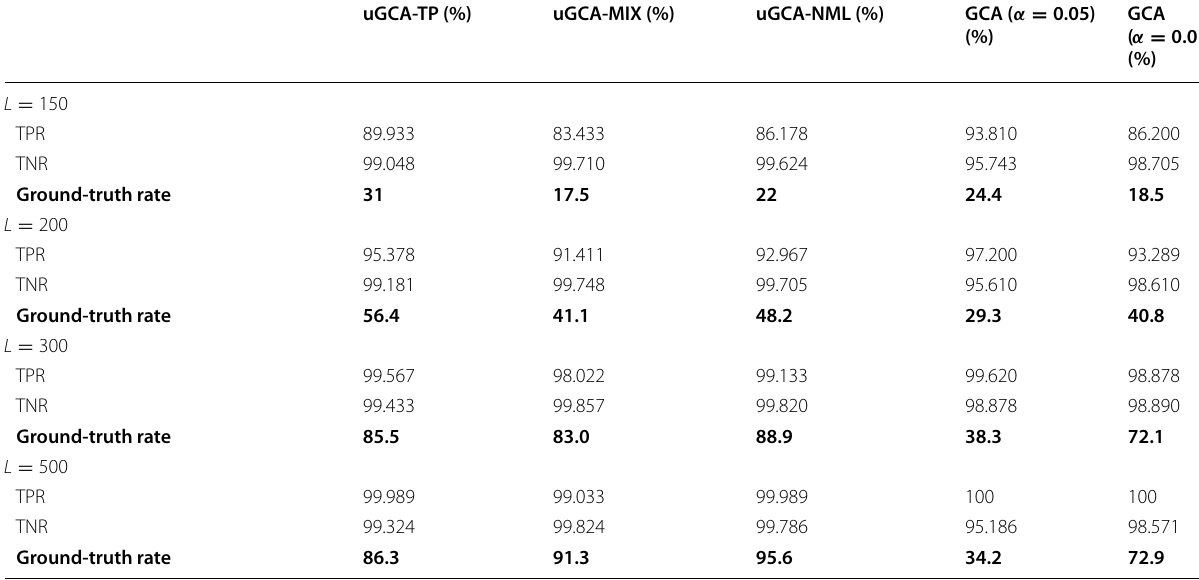
The data length ranges from 150 to 500, the results ( L = 1000 ) were present in Table 1, and L is the data length Bold values indicate more indicative of the method’s